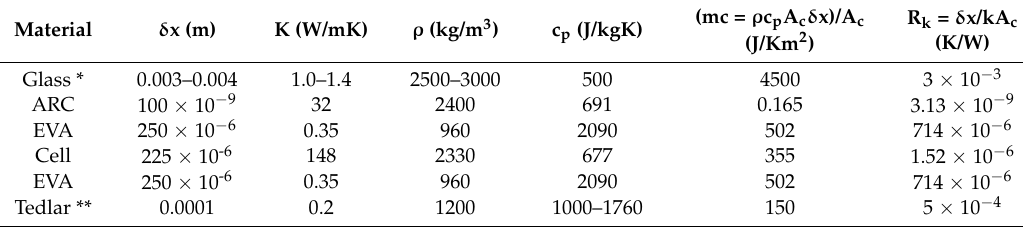
Table 1. Characteristic, average values of the thickness δ x, conductivity k, density ρ , specific heat capacity c p , mass heat capacity mc and thermal resistance R k normalised to surface area, for the PV cell